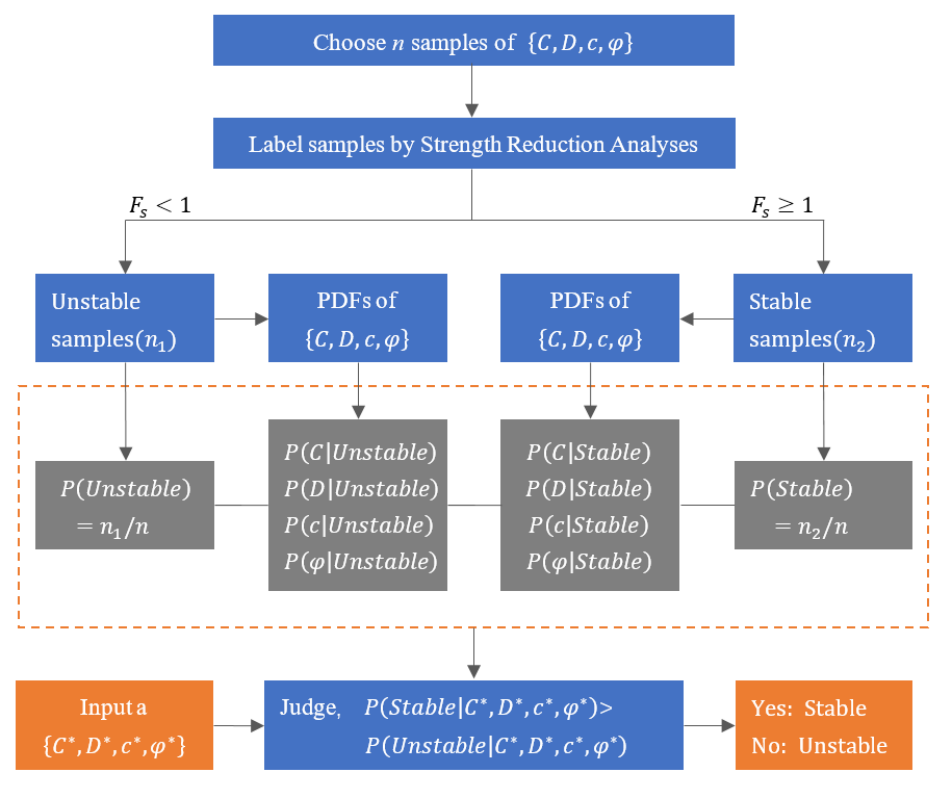
Figure 1. Framework of the proposed method.